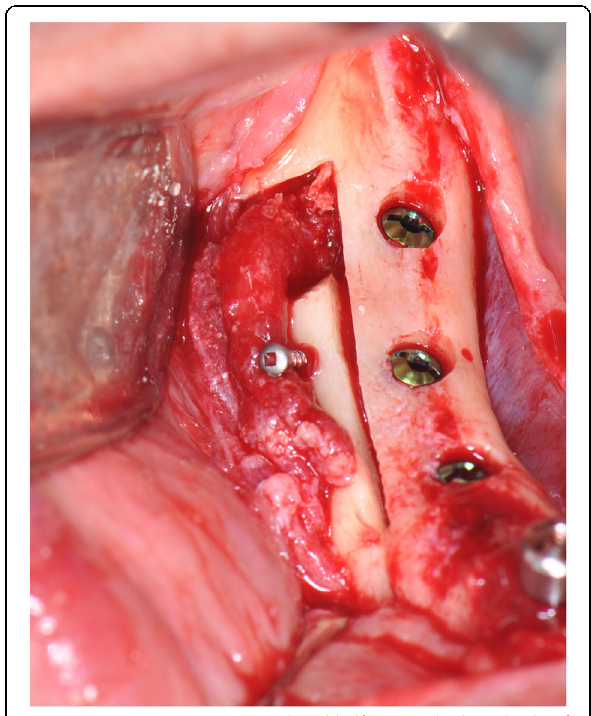
Fig. 5 A titanium mini-screw is placed halfway on the lateral side of the mandible at the upper osteotomy line